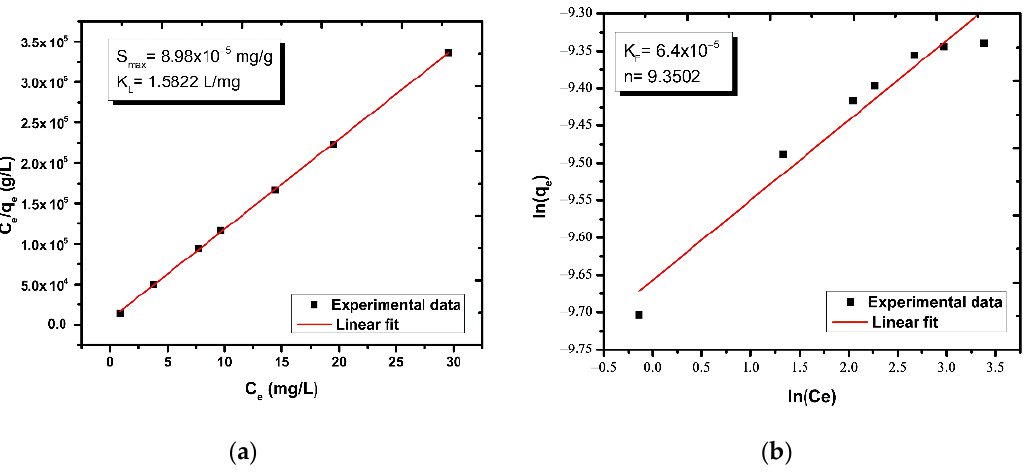
Figure 7. Linear fitting of ( a ) Langmuir and ( b ) Freundlich models.